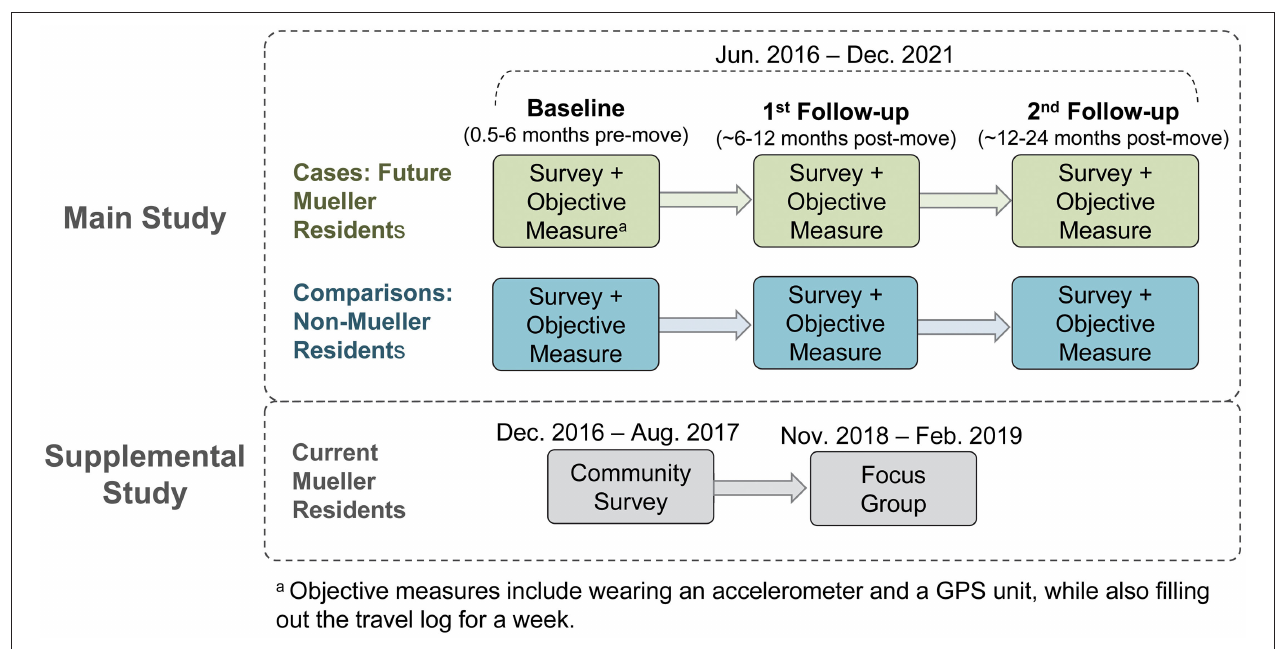
FIGURE 3 | Data collection process of the Active Living Austin